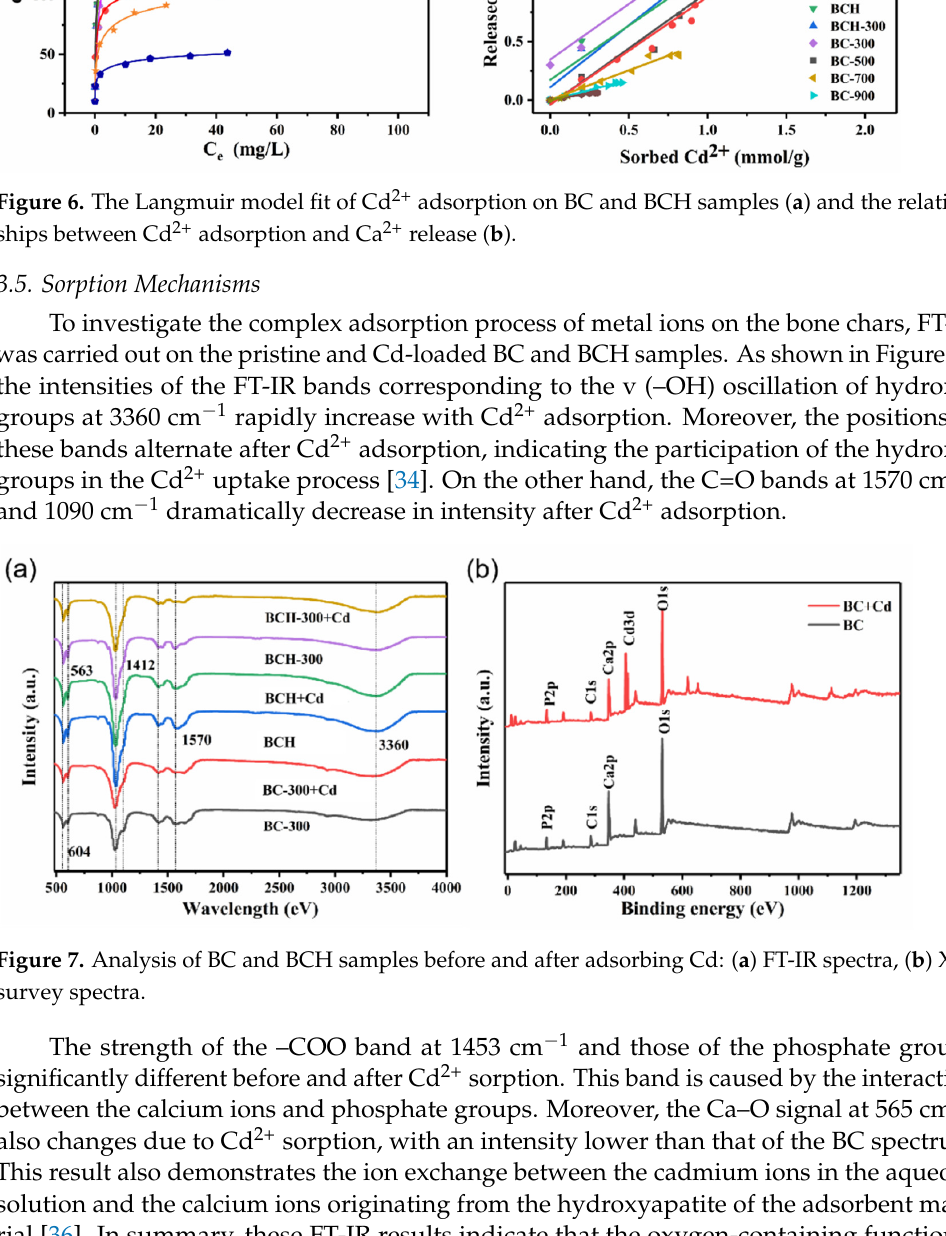
Figure 7. Analysis of BC and BCH samples before and after adsorbing Cd: ( a ) FT-IR spectra, ( b ) XPS survey spectra.